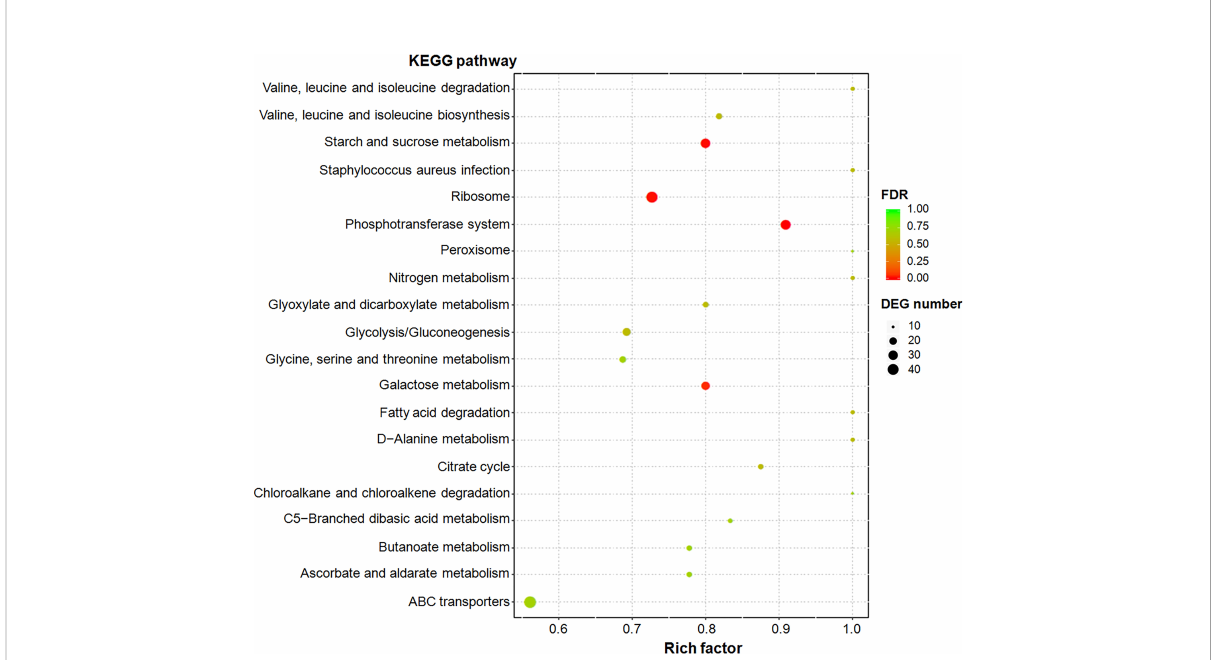
FIGURE 1 Top 20 enriched KEGG pathways of differentially expressed genes (DEGs). Rich factor refers to the ratio of the number of DEGs enriched in the pathway to the number of all genes annotated in the pathway. False discovery rate (FDR) is the corrected P -value value used in the multiple hypothesis testing (Zhang et al.,